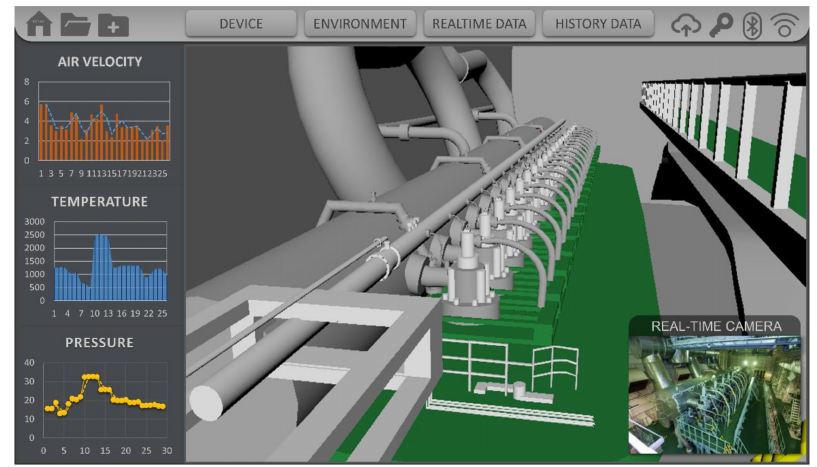
Figure 4. DT-driven platform for process management in ship engine